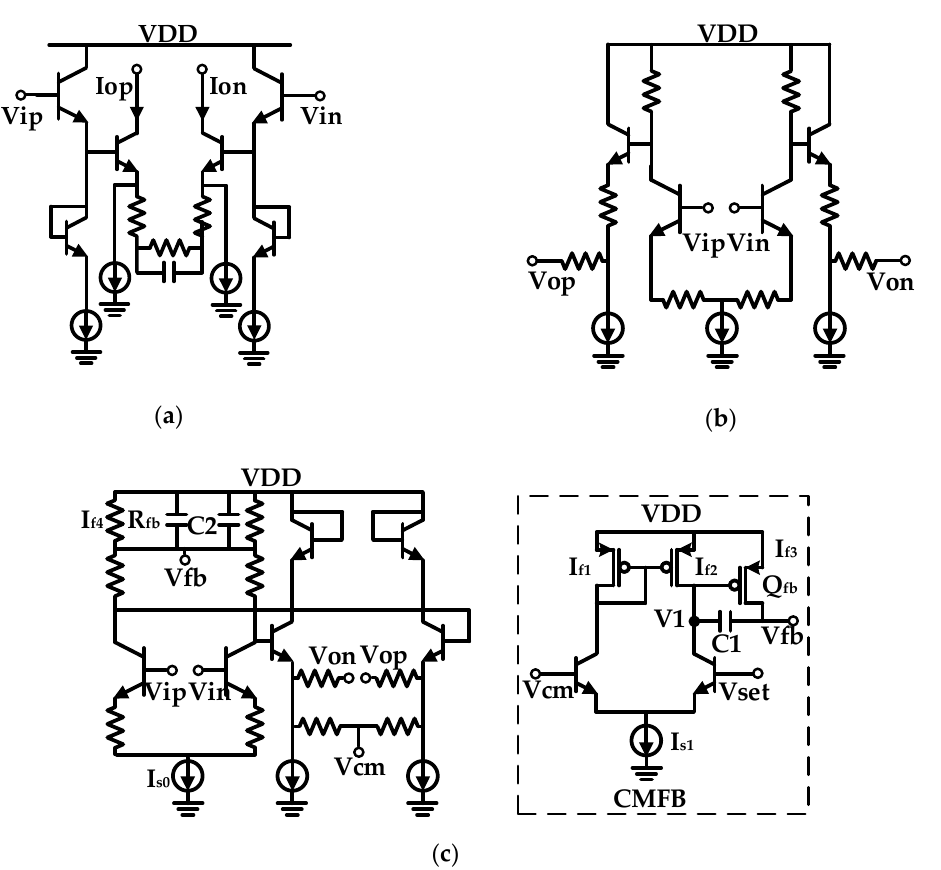
Figure 8. Schematic of data buffer: ( a ) input buffer; ( b ) output buffer; and ( c ) middle buffer.